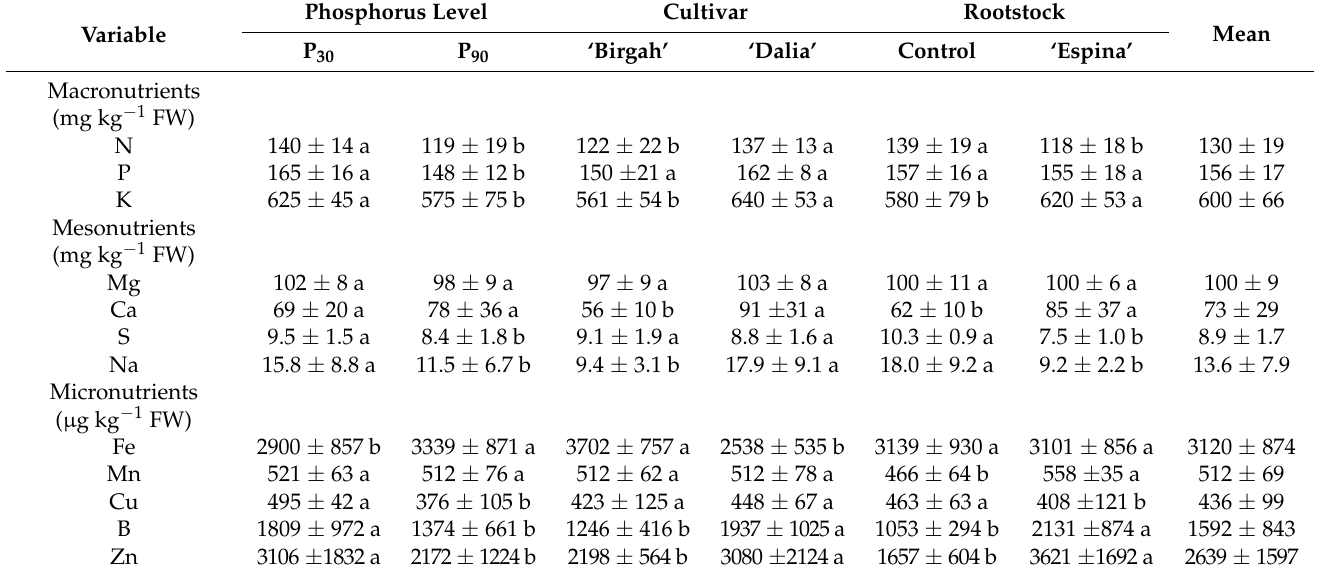
Table 3. Total N and minerals content of eggplants as affected by the main factors (mean ± standard